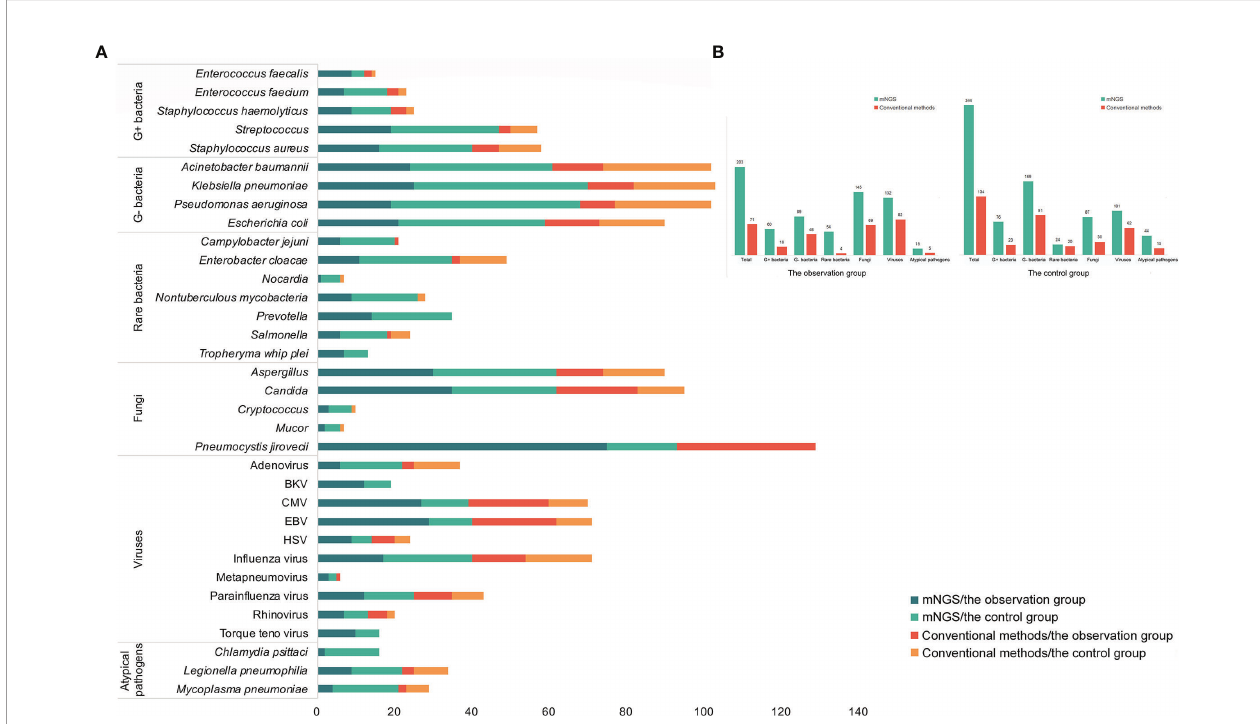
FIGURE 1 | The distribution of detected pathogens of all patients by mNGS and other clinical methods. (A) The mNGS results were shown in dark green (the observation group) and green (the control group), and the results of clinical methods were shown in red (the observation group) and orange (the control group). (B) The number of each type of pathogens detected by mNGS and clinical